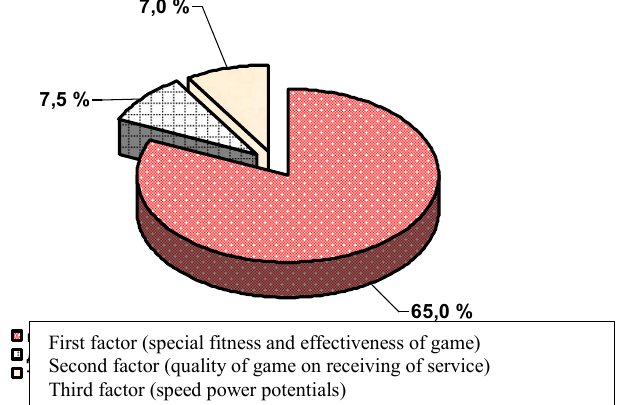
Fig.3. Factorial structure of general physical and technical-tactic fitness of 14-15 years’ age tennis players: